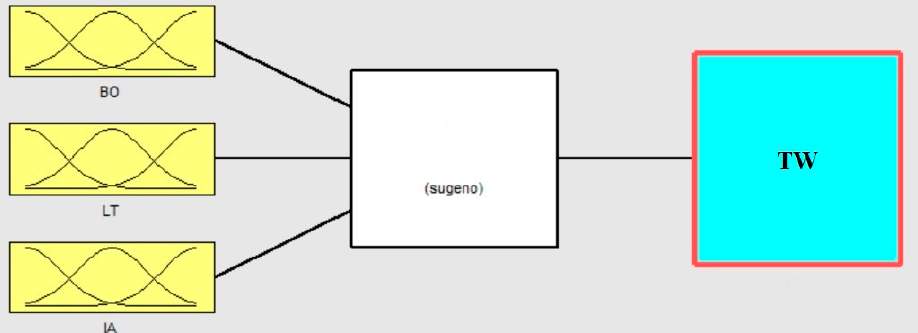
Figure 5. Fuzzy role architecture of the generalized bell membership function.